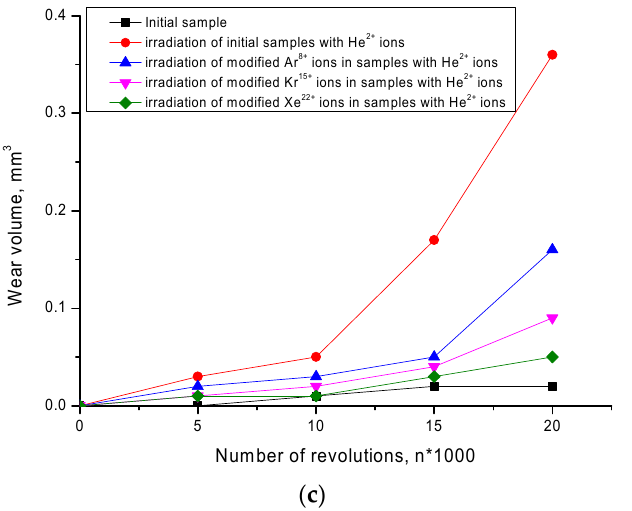
Figure 5. ( a ) Graph of the dry-friction coefficient change over 20,000 test cycles. ( b ) Dry friction coefficient reduction diagram after 20,000 test cycles. ( c ) Results of changes in volume loss during wear, depending on the type of external influences.